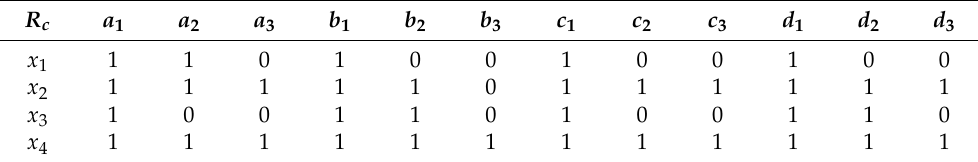
Table 2. Crisp relation associated with the context of Example